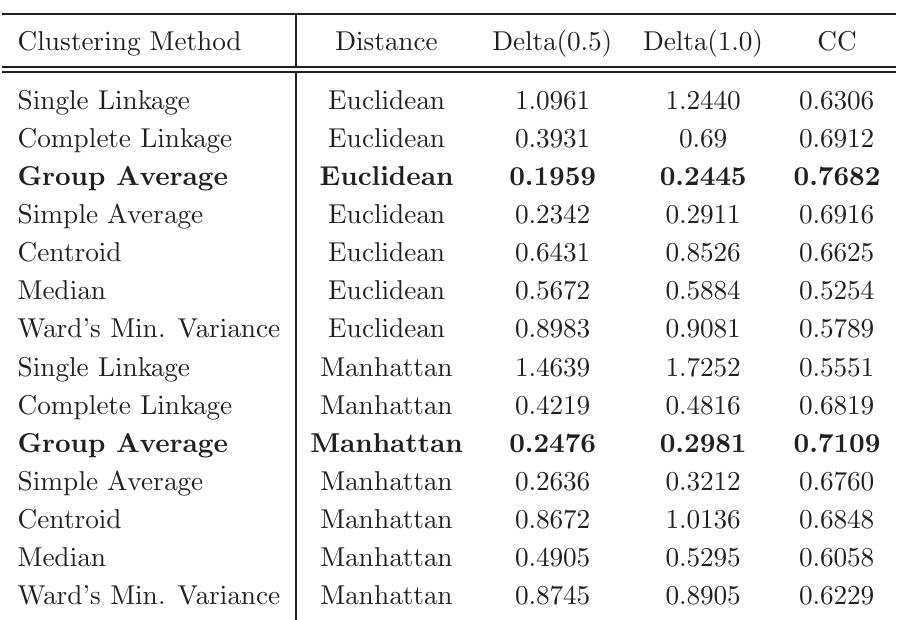
Table 4 Hierarchical clustering of the standardized geochemical data.